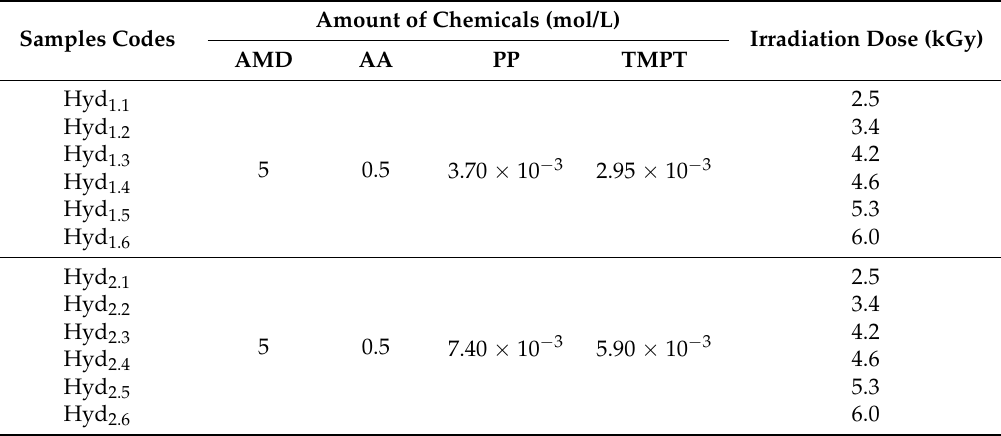
Table 2. Hydrogel synthesis